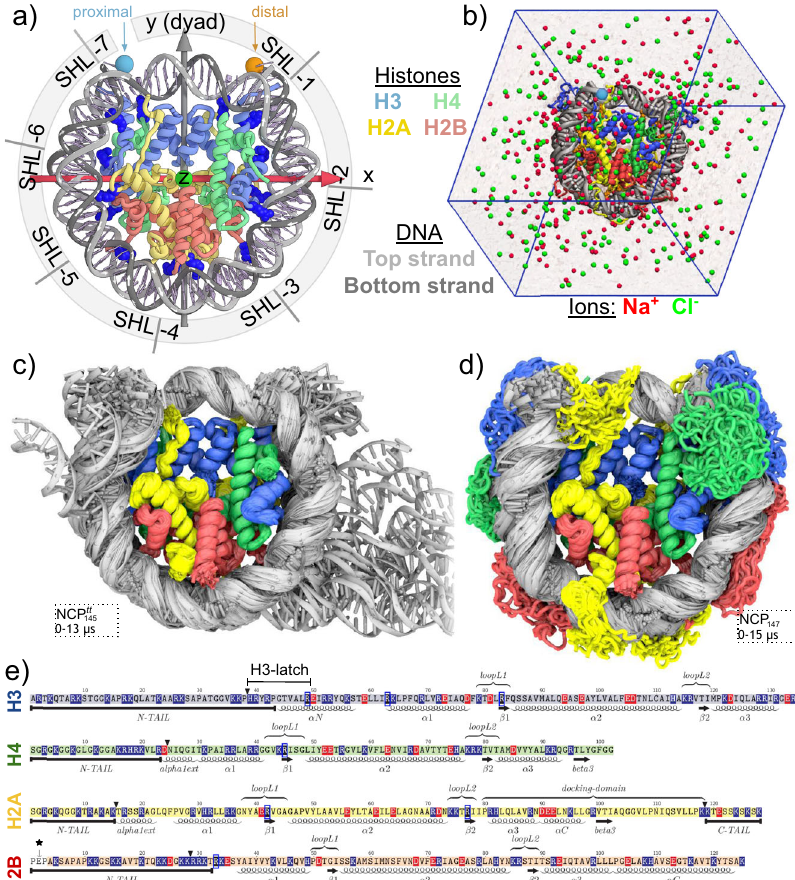
Fig. 1 Overview of NCP structure and dynamics. a NCP and its reference axes (z - superhelical, y - dyad). White arrows on DNA strands show 5 ′ -3 ″ direction. Spheres highlight the proximal and distal ends of the double helix. Superhelical locations (SHL) are shown for the proximal half of the DNA (SHL < 0). Proximal H3-H4/H2A-H2B dimers are in the front (z > 0). Key arginines inserted in DNA minor grooves are shown in dark blue. b NCP in a simulation box with solvent. c , d Dynamics of NCP with truncated and with full-length histone tails (NCP tt 145 and NCP 147 systems, respectively). Overlay of MD snapshots spaced 0.1 µ s apart. e Sequences of the core histones and their secondary structure features: α -helices, β -strands, loops, fl exible histone tails, etc. For simulations with truncated histone tails, the respective positions are marked with black triangle. Positively and negatively charged residues are highlighted in blue and red, respectively. Key arginines are highlighted with dark blue frames. Black asterisk - H2B residues absent in the recombinant